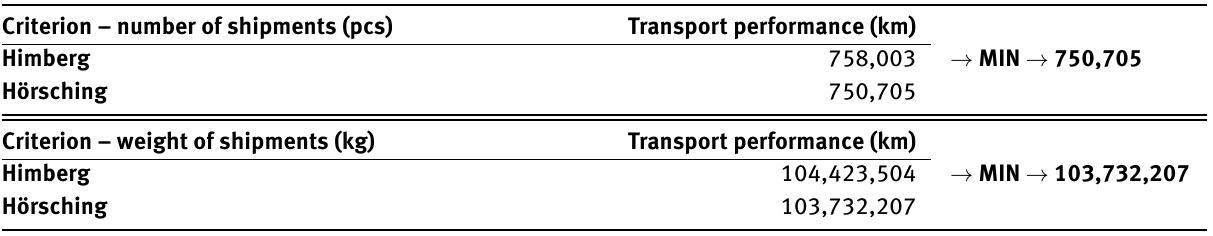
Table 4: Visual representation of the application of location problem Criterion – number of shipments